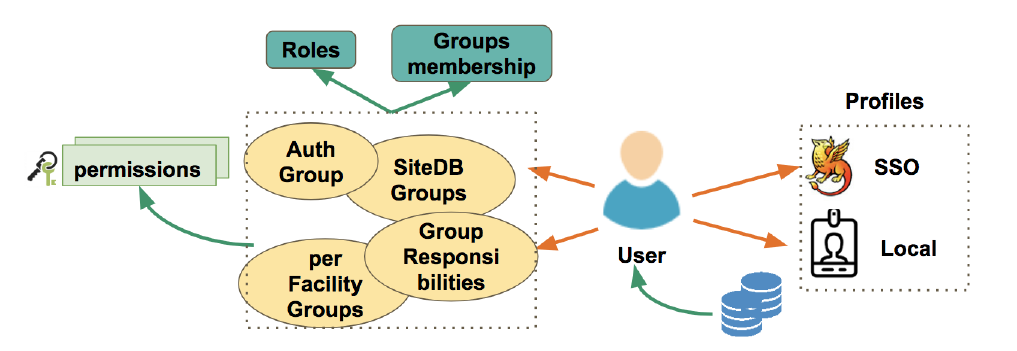
Figure 2. CRIC’s Authentication and Authorization Figure 1. CRIC’s architecture